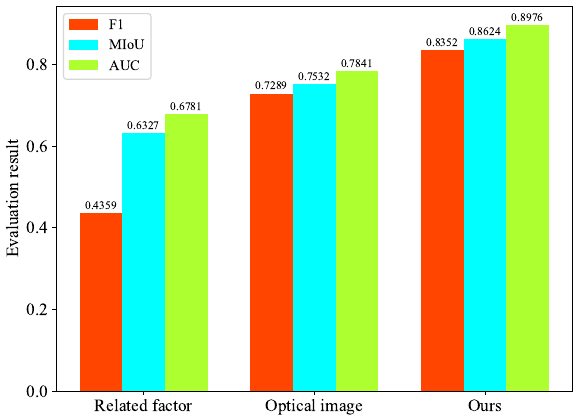
Figure 6. Evaluation results of 3 types of sample input methods. model using optical remote sensing image. The best recogni- tion accuracy of our model can also be reflected from the MIoU values.